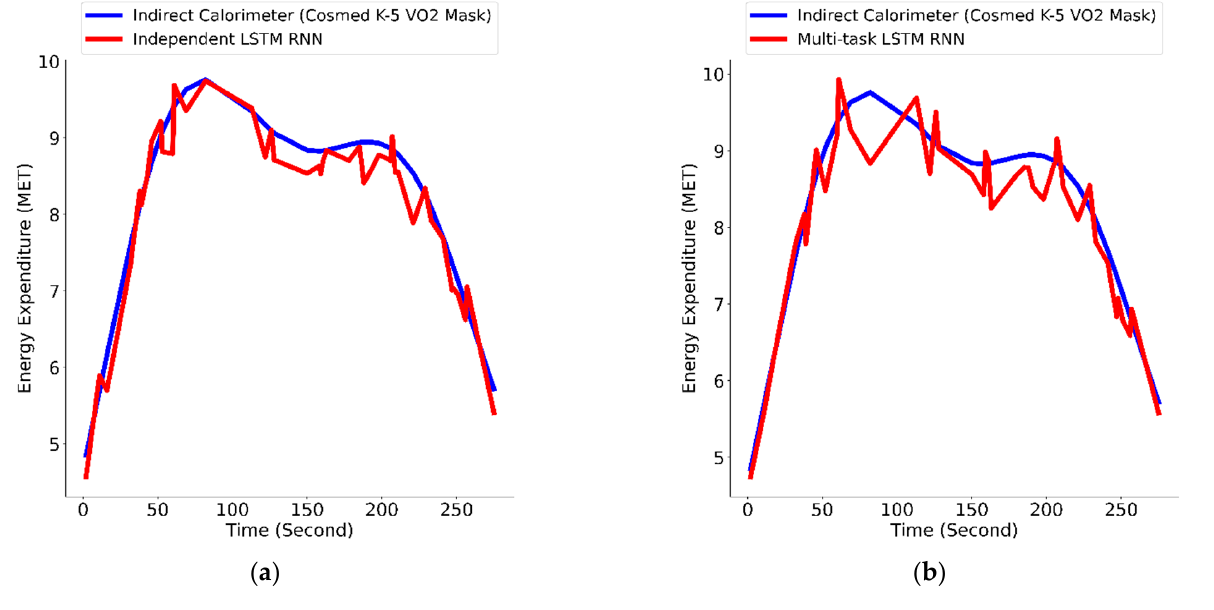
Figure 10. EE estimation using an independent testing data. ( a ) EE estimated using the independent LSTM RNN model versus the measured EE by the indirect calorimeter. ( b ) EE estimated using the multi-task LSTM RNN model versus the measured EE by the indirect calorimeter.